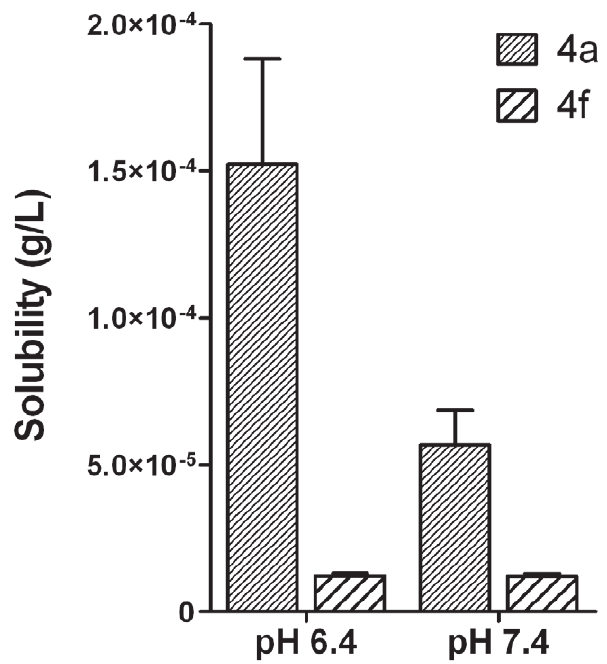
Figure 9. Aqueous solubility of compounds 4a and 4f in phosphate buffer at pH 6.4 and 7.4. Bars represent the mean 6 S.E.M. of n=3 independent measurements for each pH.